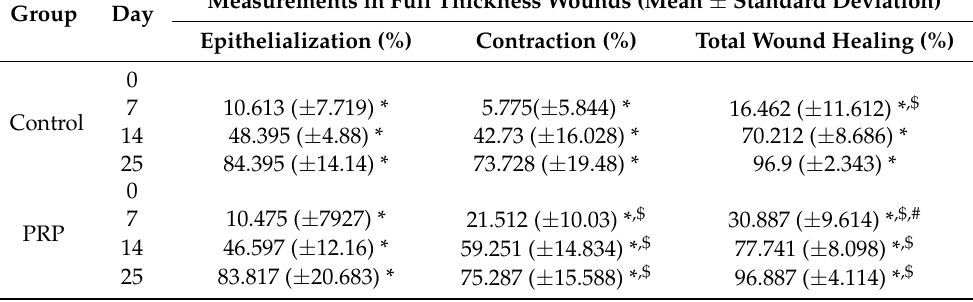
Table 3. Epithelialization, contraction, and total wound healing percentages in all measurement times in the eight cats. PRP: platelet-rich plasma.